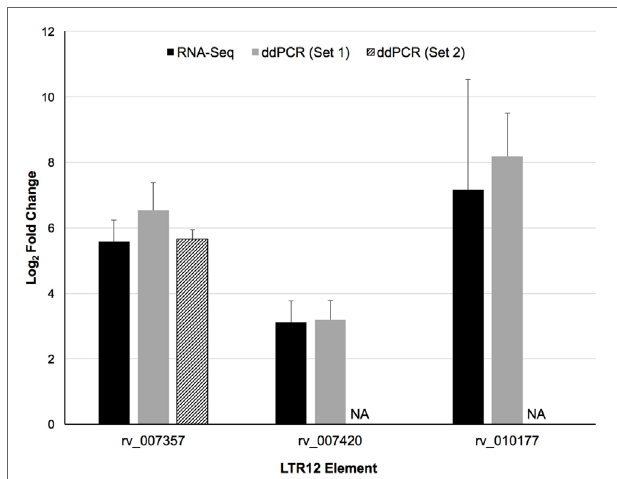
FigUre 3 | Confirmation of the upregulation of three distinct LTR12 elements by vorinostat in primary CD4 + T cells using droplet digital PCR (ddPCR). Log 2 fold changes between vorinostat treated and untreated conditions were averaged across all four donors (Donors 1–4) for the RNA-Seq (black bars) and the ddPCR (gray and hatched bars) data for each LTR12 element. Error bars represent SDs across donors. The labels “Set 1” and “Set 2” indicate the two distinct primer and probe sets used to target the same LTR12 element (i.e., rv_007357). A second primer and probe set was not used to target the other LTR12 elements, and the missing bar is thus labeled “NA” for not applicable. LTR12 elements are labeled with their “rv” designation from the Human Endogenous Retrovirus